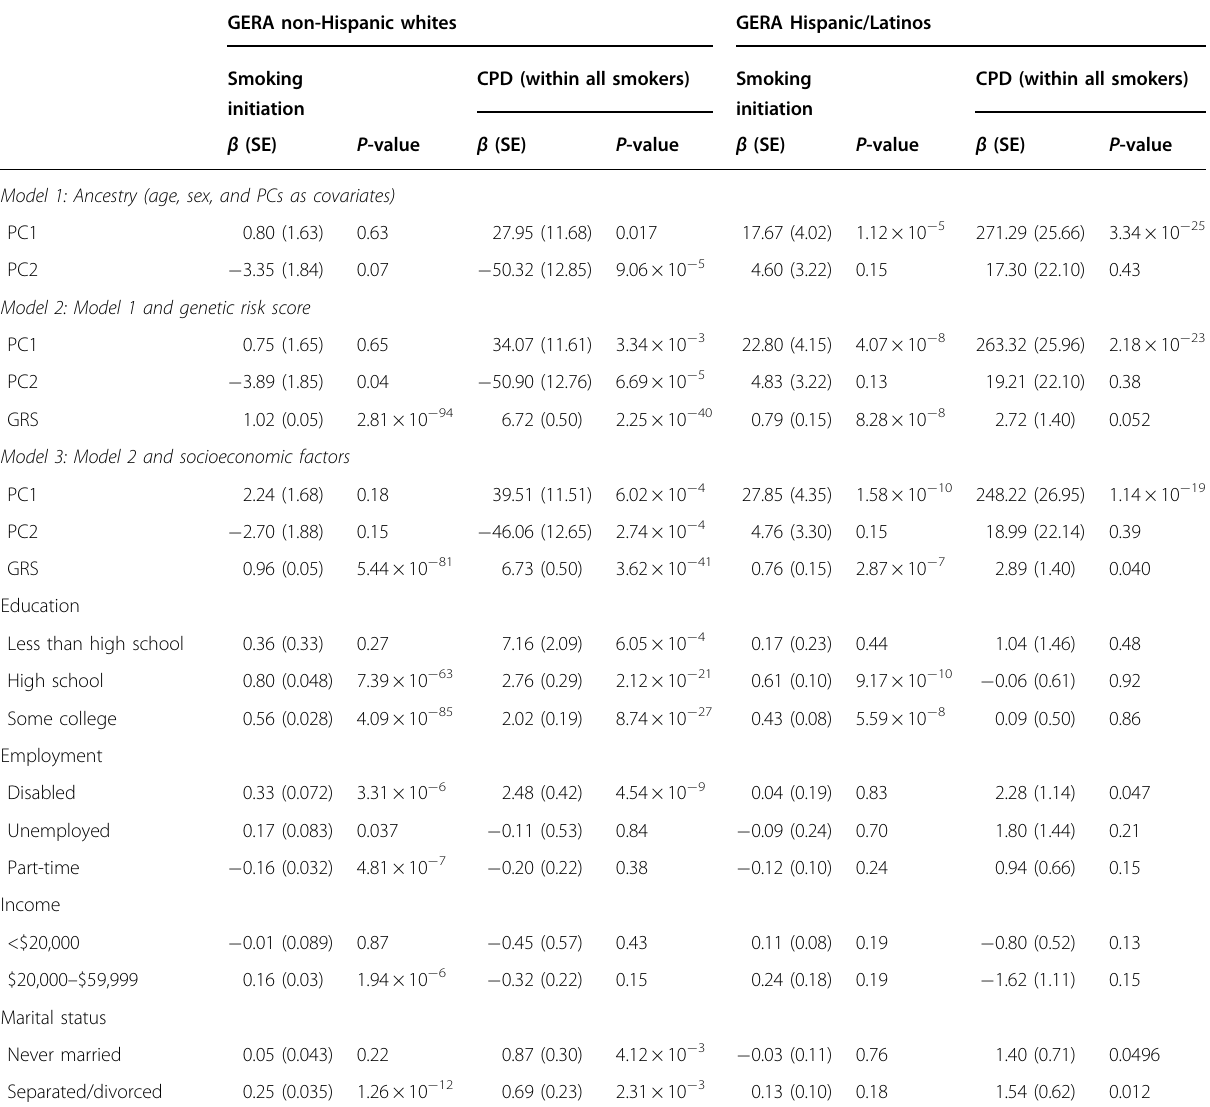
Table 2 Associations between genetic ancestry and smoking-related phenotypes in GERA non-Hispanic whites and